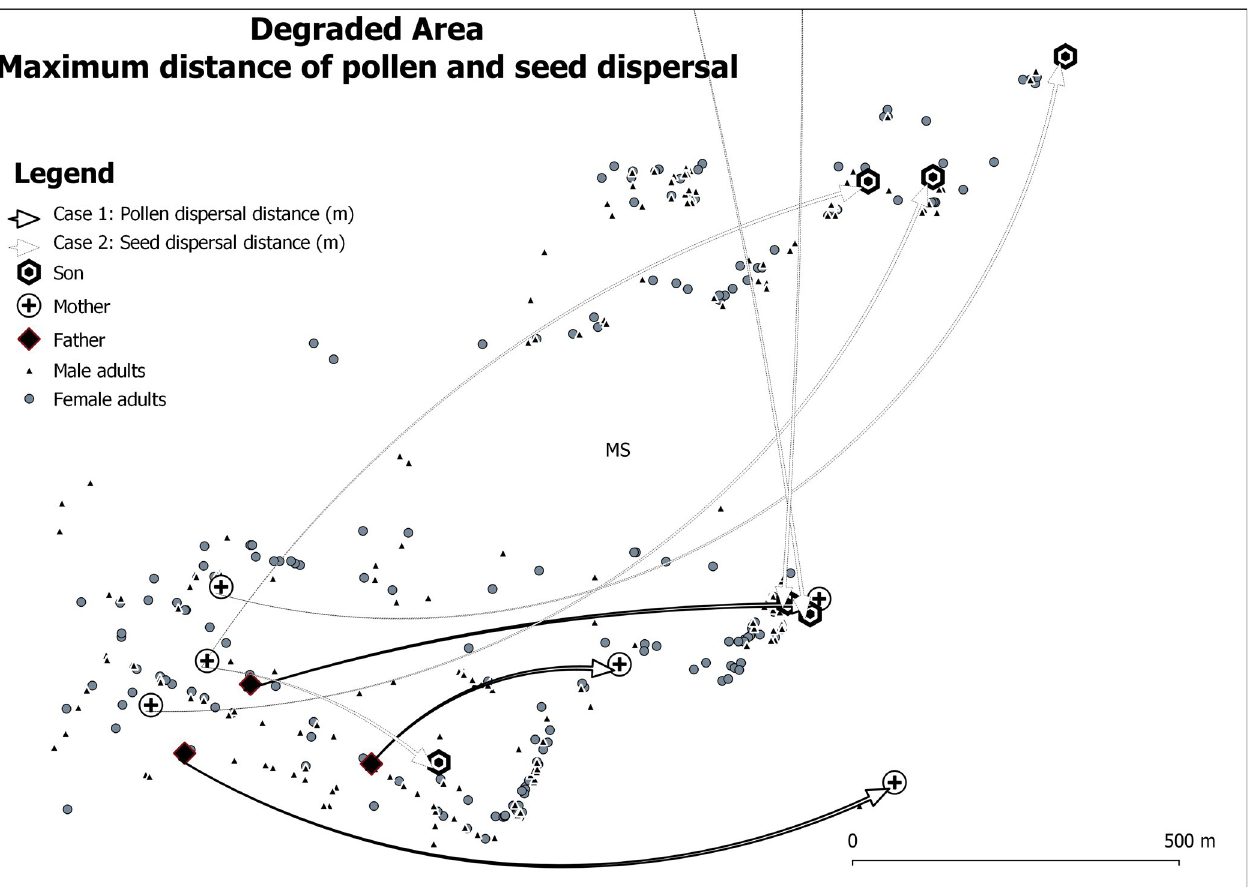
Fig 4. Spatial patterns of parentage identified in the degraded area. Arrows indicate the direction of the most distant identified pollen and/or seed donors.